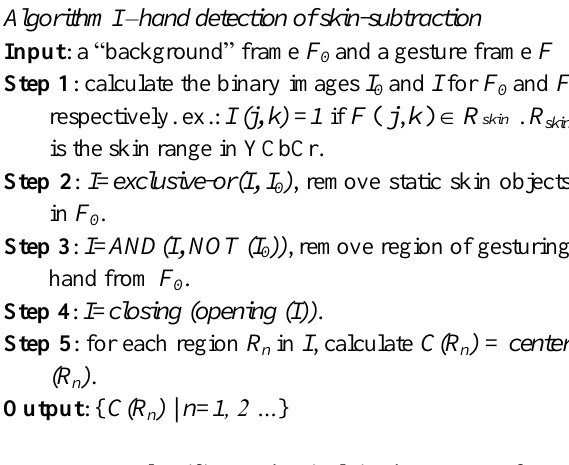
Algorithm I –hand detection of